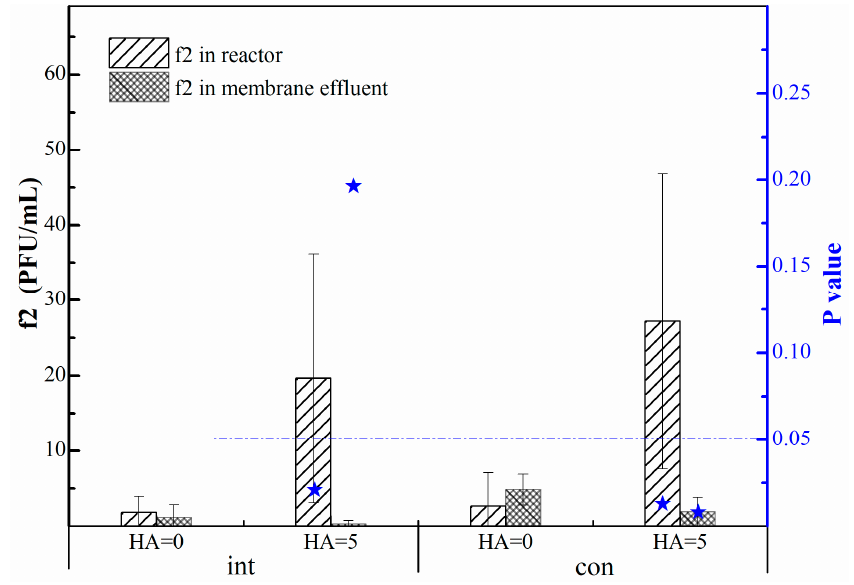
Figure 5. Influence of humic acid on disinfection of Photocatalytic Membrane Reactor (PMR) under different operation mode.